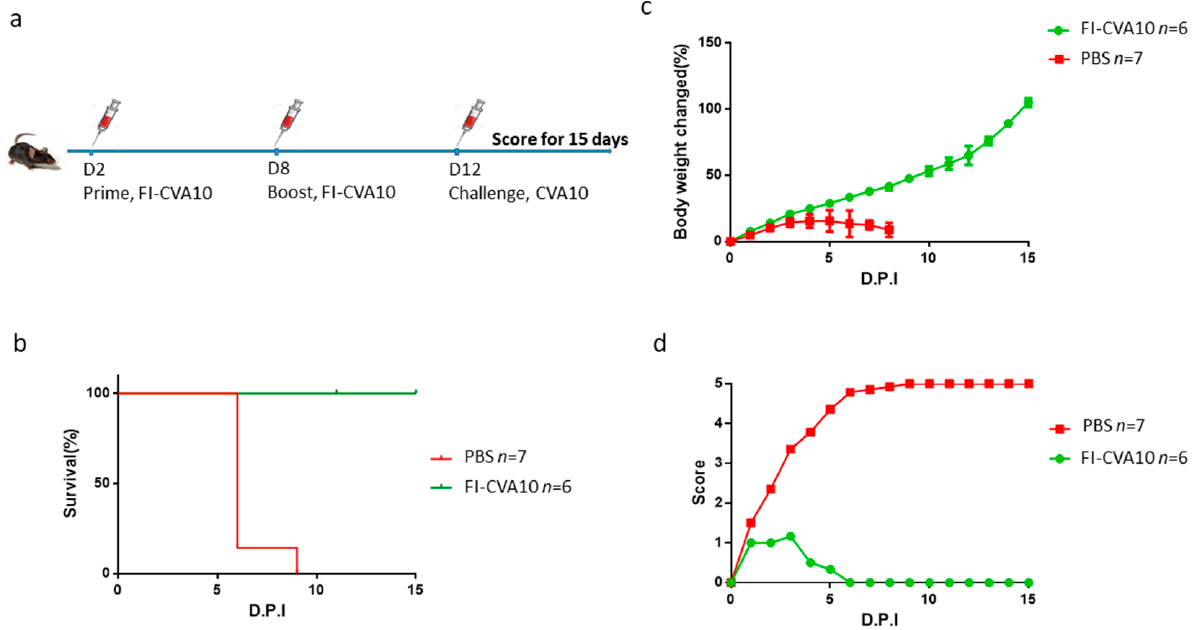
Figure 6. Protection of hSCARB2-Tg mice from CVA10 challenge by FI-CVA10 vaccine. ( a ) The flowchart of vaccine immunization following the challenge of CVA10 in Tg mice was shown. One- day-old Tg mice were s.c. immunized with two doses of FI-CVA10 vaccine or PBS on day 2 and day 8, following s.c. injection of 1.72 × 10 7 pfu of CVA10 on day 11 was performed. Daily recording of ( b ) percentage of mice survival, ( c ) loss of body weight, and ( d ) disease score for 15 days of hSCARB2-Tg mice receiving PBS or FI-CVA10 was performed. Data represent the mean scores ob- tained from the individual number of ( n ) mice per group.